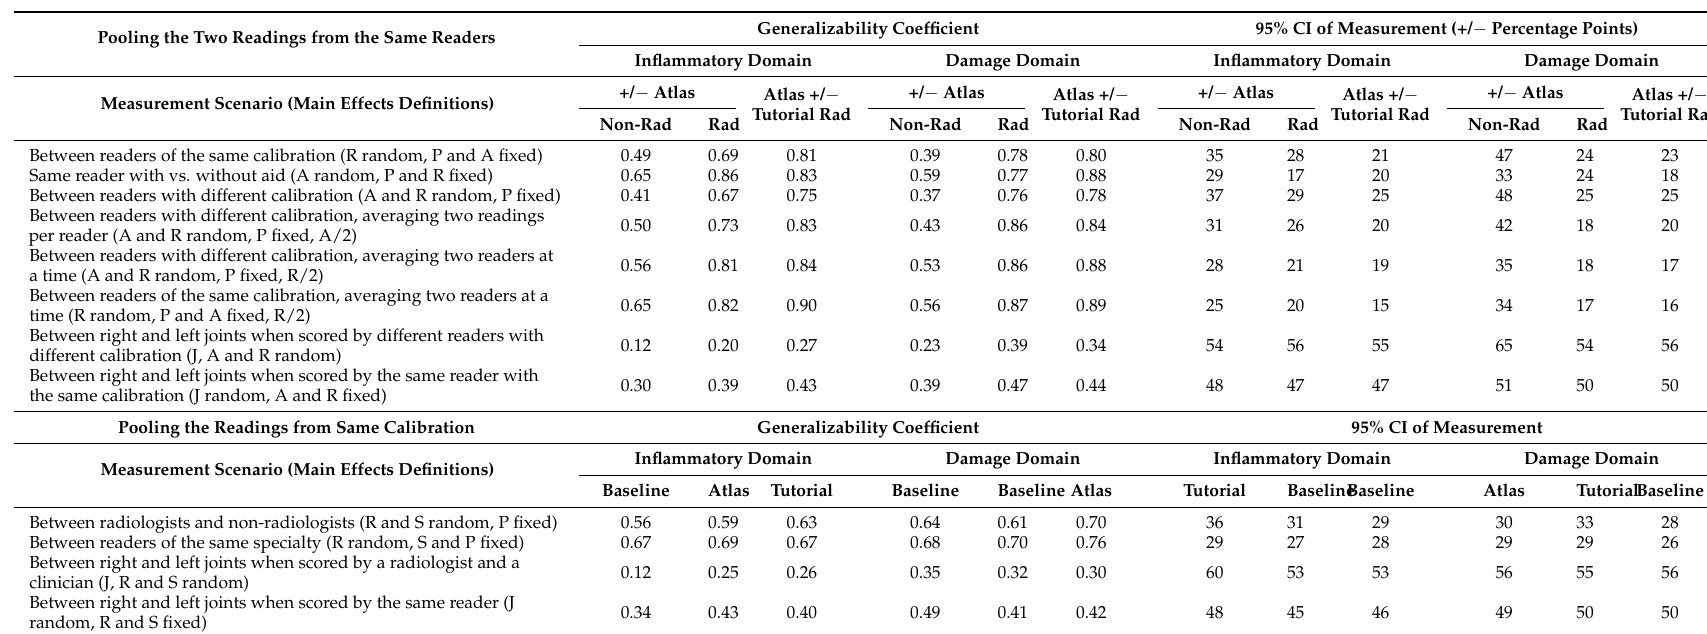
Table 3. Three-facet generalizability coefficients. Agreement on TMJ score with three sources of variance—patient, reader and aid or reader specialty. The 95% confidence interval of measurement reflects the measurement error interval around a measured score, in the units of the respective JAMRIS-TMJ domain. Abbreviations: A, aid; J, temporomandibular joint; Non-Rad, non-radiologist clinician reader; P, patient; R, reader; Rad, radiologist reader; S, specialty (binary, radiologist or non-radiologist clinician). Pooling the Two Readings from the Same